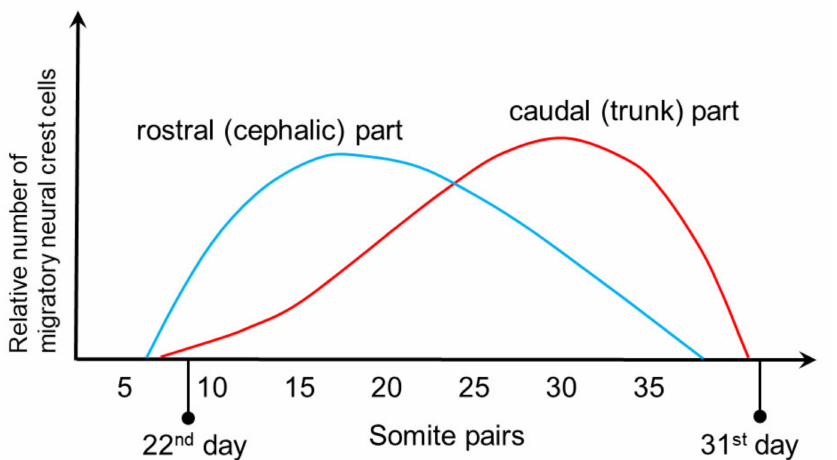
Figure 3. Schematic representation of the dynamics of neural crest cell migration in the rostral and caudal part of the human embryo. Migration begins around day 22 and ends by day 31 of gestation. The total number of somites in human is 37 as out of the original 42–44, some of the most caudal ones rapidly disappear